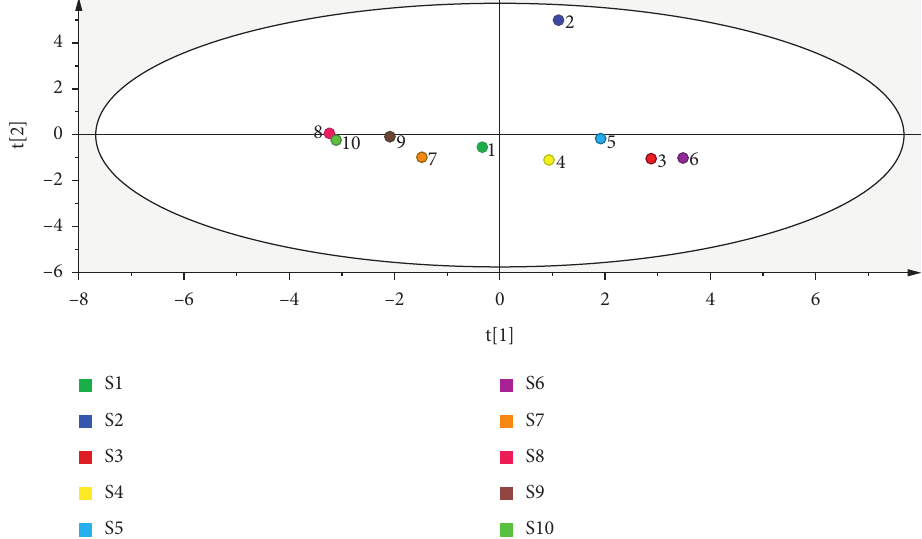
Figure 7: Principal component analysis score chart.